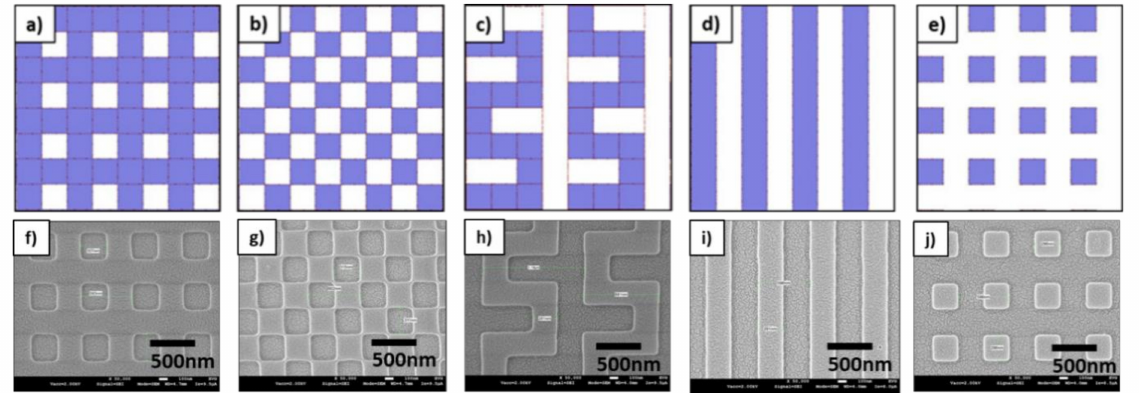
Figure 4. Schematic illustration of the different geometrical layouts used to investigate the filling behavior of nanostructures: ( a ) Crossbar, ( b ) checkerboard, ( c ) meanders, ( d ) line and space (L/S), and ( e ) pillars. Pattern dimensions of 300 nm with a depth of 110 nm have been selected for comparison and respective SEM images of SmartNIL replications are shown from ( f – j